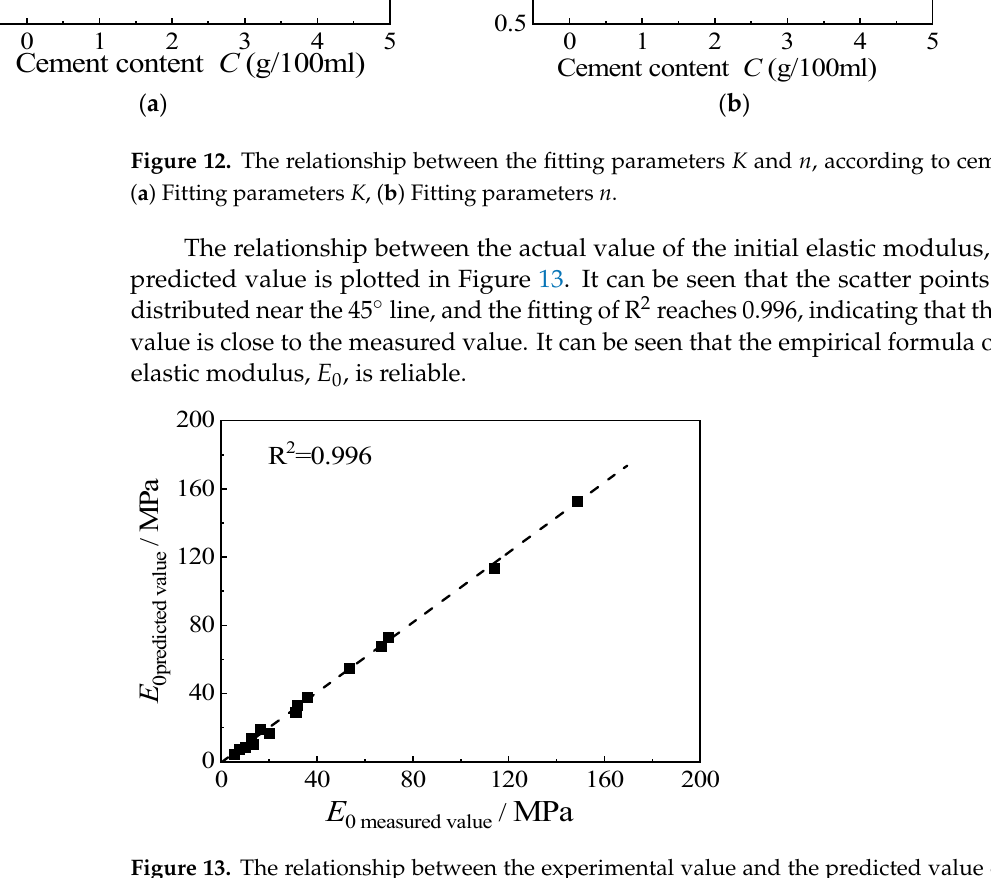
Figure 13. The relationship between the experimental value and the predicted value of the initial elastic modulus.